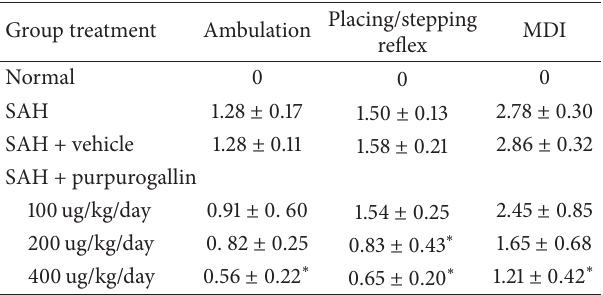
Table 1: Modified limb-placing test (MLPT).